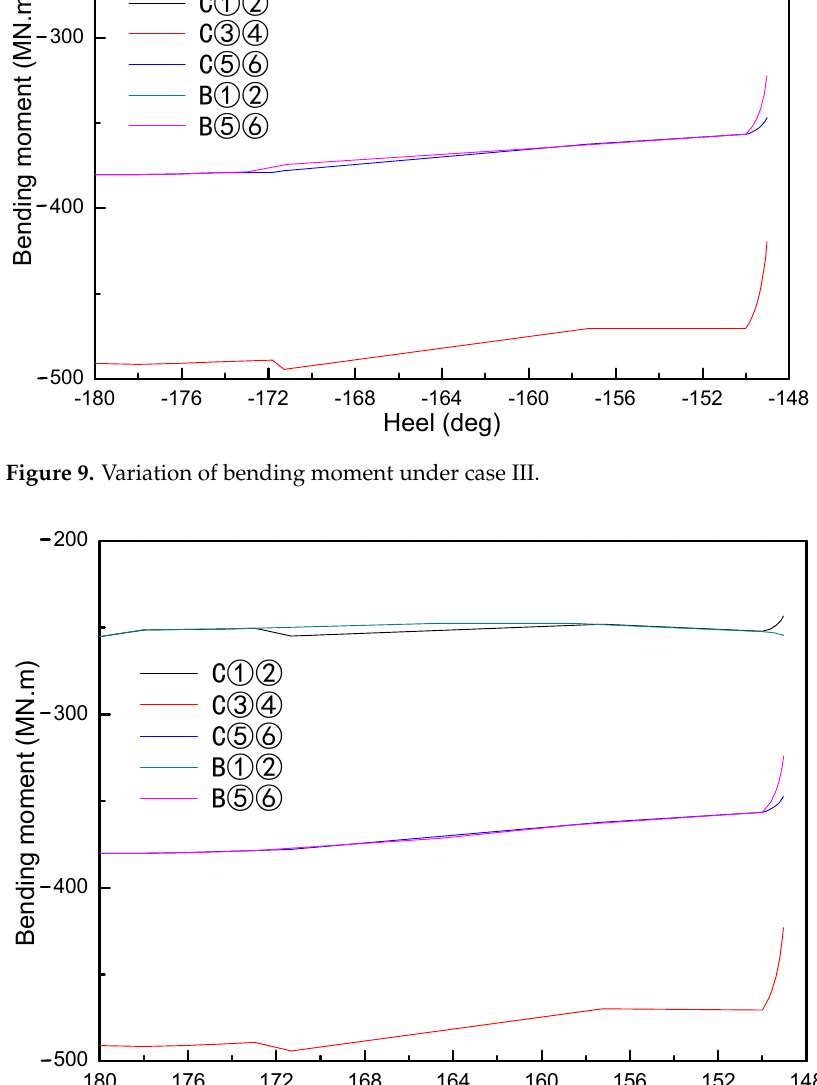
Figure 10. Variation of bending moment under case Ⅳ .